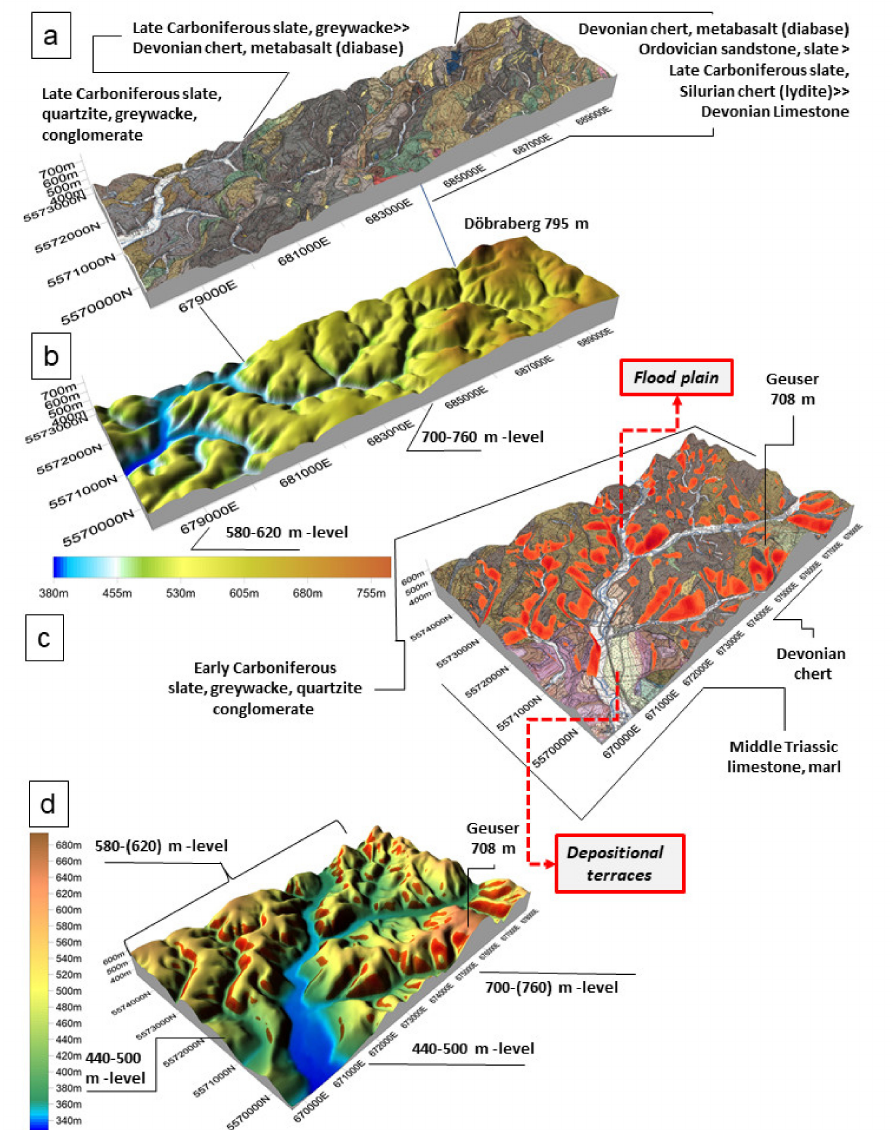
Figure 3. The drainage system in the Frankenwald (FW) (Table 1-VLG-type) in digital ter- rain models (DTM) The V-shaped valleys are highlighted by the slope angle shaded in red (see angle bar = midslope). Rectangles framed in red denote landforms of fluvial relevance. ( a ) Geol- ogy and the geomorphological setting in the upper reaches (headwaters = (CA)) transitional into the proximal transport area (TA)); ( b ) Excerpt of the topography and the level of paleosurfaces of ( a ); ( c ) Geology and the geomorphological setting in the lower reaches (distal TA transitional into the depositional area (DA) within the basement and proximal foreland); ( d ) Excerpt of the topography and the level of paleosurfaces of ( c